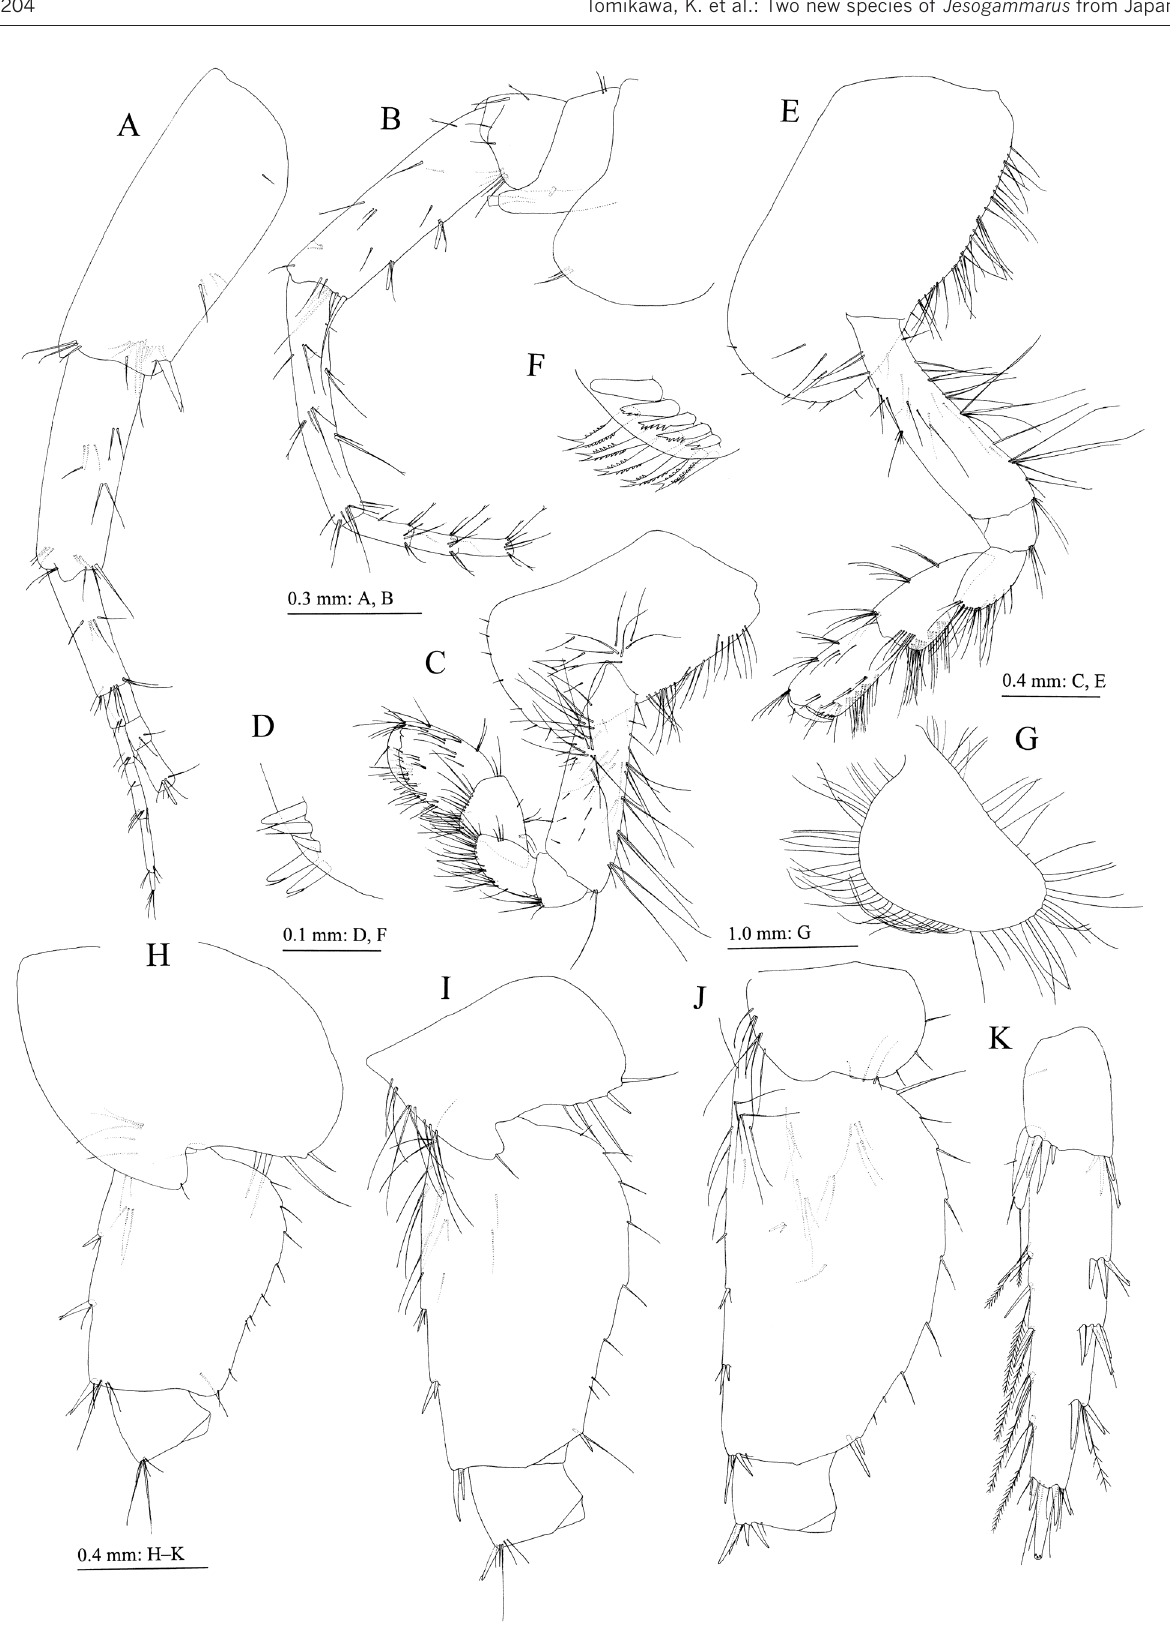
Figure 13. Jesogammarus uchiyamaryui sp. n., paratype, female (9.2 mm), NSMT-Cr 25475. A peduncular articles 1–3, accessory flagellum, and flagellar articles 1–3 of antenna 1, medial view; B peduncular articles 1–5 and flagellar articles 1–3 of antenna 2, medial view; C gnathopod 1, lateral view; D palmar margin of propodus of gnathopod 1, lateral view; E gnathopod 2, lateral view; F palmar margin of propodus of gnathopod 2, lateral view; G brood plate of gnathopod 2, lateral view; H coxa–ischium of pereopod 5, lateral view; I coxa–ischium of pereopod 6, lateral view; J coxa–ischium of pereopod 7, lateral view; K uropod 3, dorsal